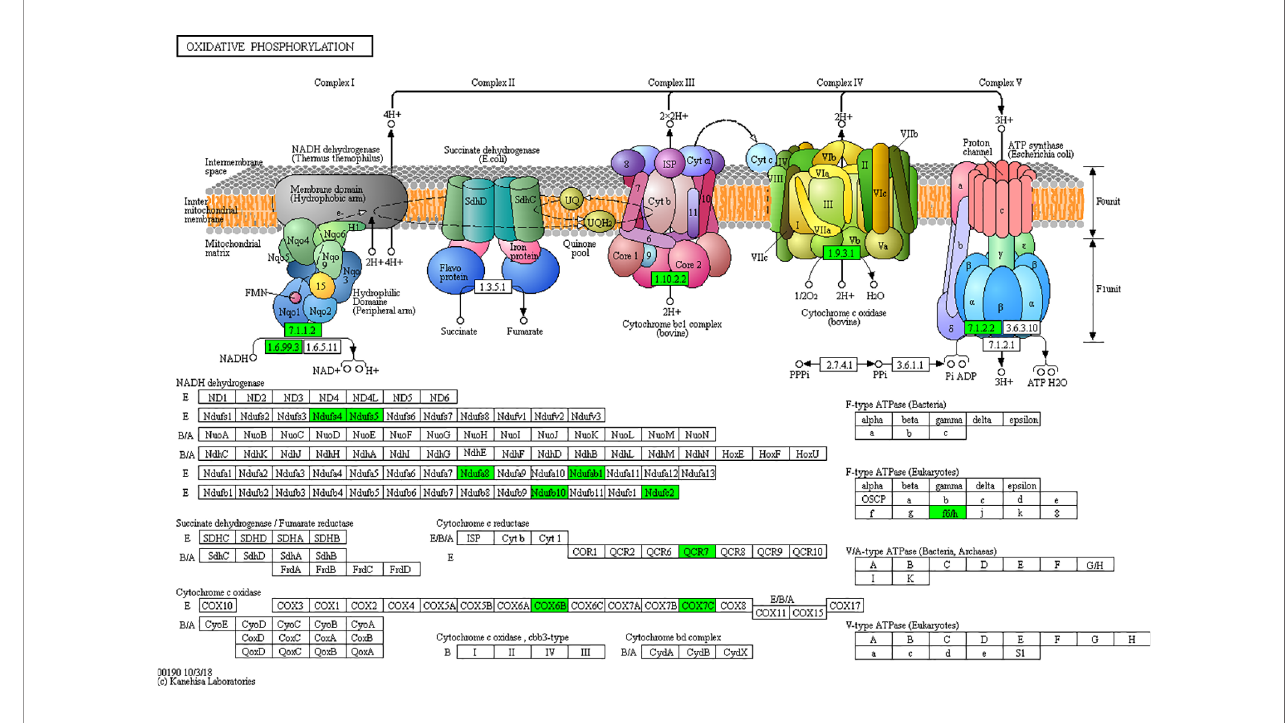
FIGURE 10 | Network of oxidative phosphorylation.